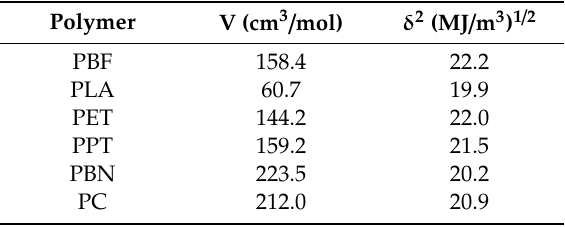
Table 1. Molar volumes and solubility parameter values for the polymers used in blends. PBF—poly(butylene 2,5-furandicarboxylate); PLA—poly(lactic acid); PET—poly(ethylene